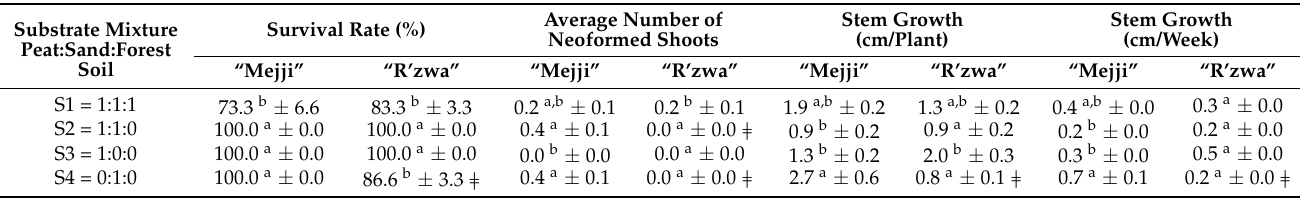
Table 2. Effects of different substrate mixtures on survival rate, the number of neoformed shoots and stem growth during ex vitro acclimatization of argan plantlets.